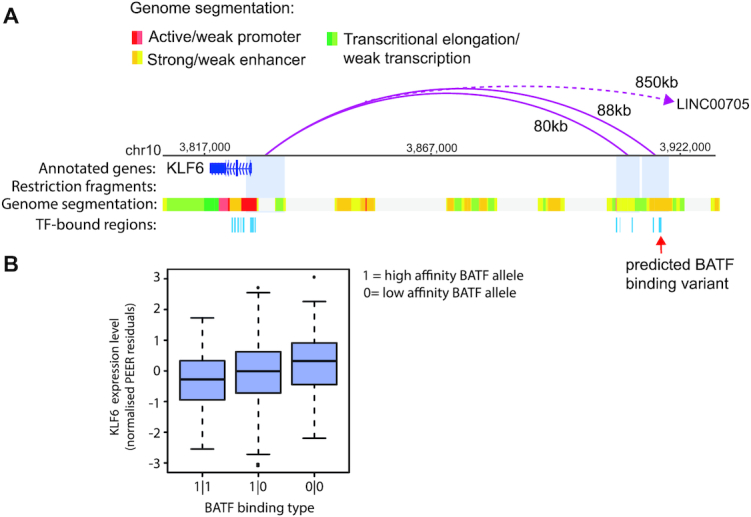
Example of association between a TF binding affinity CRM variant and gene expression. (A) Genome browser representation of the distal interactions (pink arches) of KLF6 promoter in the LCL GM12878, as detected by PCHi-C (49). Two out of the three fragments interacting with KLF6 promoter are shown; the third fragment, which is located 850 kb away from the KLF6 promoter and contains the gene LINC00705, was omitted due to space constraints. The chromHMM genome segmentation tracks for GM12878 are shown immediately below (80). CRMs at the two distally interacting fragments and the TSS-proximal window are depicted in azure blue. The rightmost CRM, which interacts with the KLF6 promoter 88 kb away, is predicted to impact BATF binding affinity across the 359 LCLs. (B) Box plot showing the association between mRNA levels (as measured with RNA-seq by the GEUVADIS consortium) and predicted CRM haplotype with respect to BATF binding affinity in LCLs. KLF6 expression is significantly associated with BATF binding type (gene-level FDR adjusted P-value = 1.21 × 10−2, BATF variant P-value = 5.16 × 10−4, effect size = 0.26).